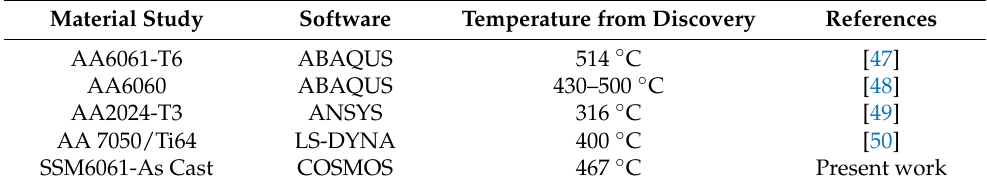
Table 7. Summary of transient thermal characteristics of FSSW in previous